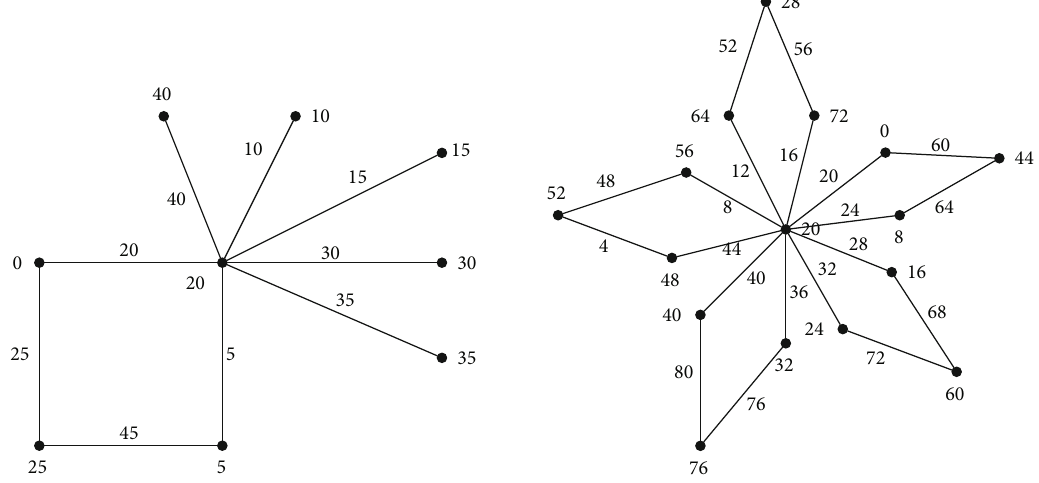
Figure 1: A graph with edge 5 − graceful labeling and an edge 4 − graceful labeling of another